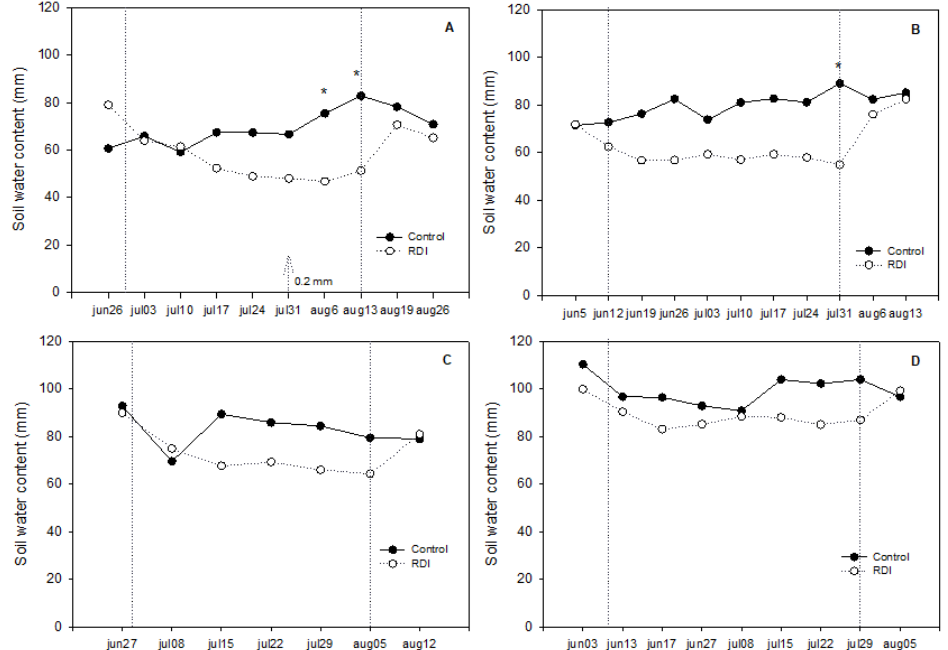
Figure 3. Soil water content at 45 cm depth in control and regulated deficit irrigated (RDI) vines cultivated under net (left, A and C ) and under a plastic greenhouse (right, B and D ) in 2015 (top) and 2016 (bottom). Vertical lines mark deficit irrigation periods. Arrows represent the rain events during the deficit irrigation period. When present, * indicates significant differences between irrigation treatments ( p < 0.05). Plants 2020 , 9 , x